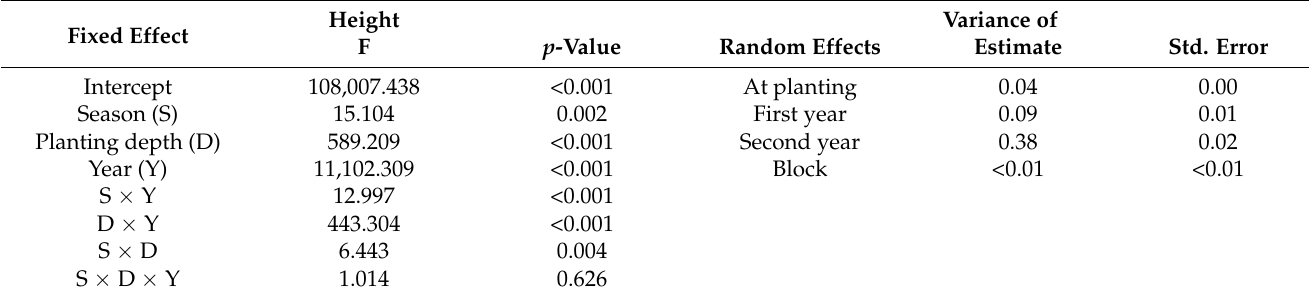
Figure 3. Height development of autumn- and spring-planted Scots pine seedlings in 2019–2020 at planting depths of 2, 5 and 8 cm (length of belowground shoot). The seedlings were measured at the time of planting, and after the first and second growing seasons. Vertical bars indicate the standard error of the means ( n = 90–98). The different letters indicate statistically significant differences among planting depths in the inventory year. Asterisks (*) indicate statistically significant differences between the planting seasons at particular planting depths in each year. Table 2. Repeated (year Y) linear mixed model analysis for the effects of planting depth (D) on the height and diameter of silver birch seedlings. The variance of random effects of each planting year and block are also